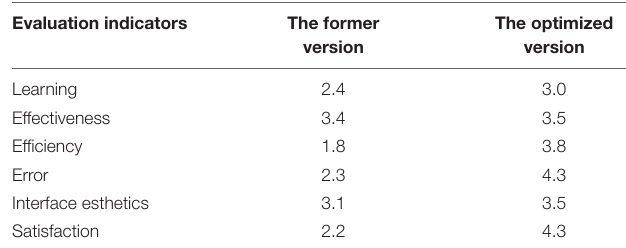
TABLE 4 | Evaluation